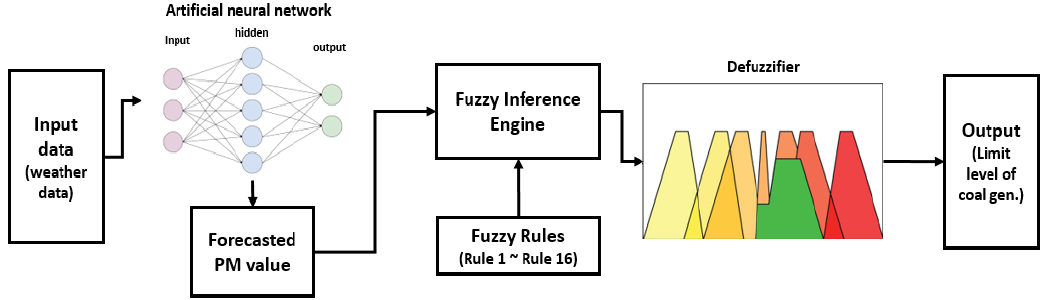
Figure 3. Overall schematic of the proposed model.